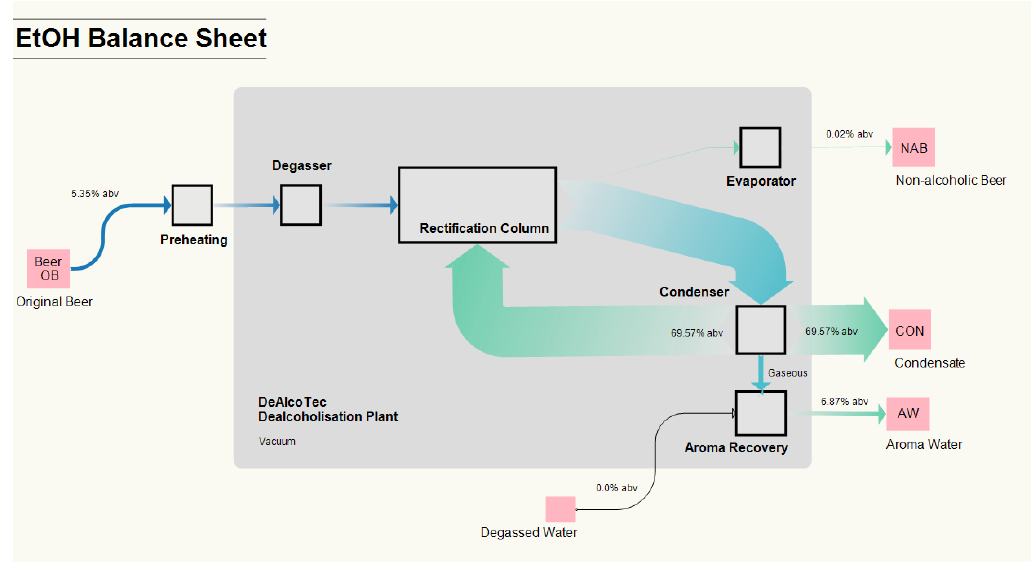
black squares/rectangles represent the single unit operations in the system. The isobaric area under vacuum is assumed to be the greyed system area.